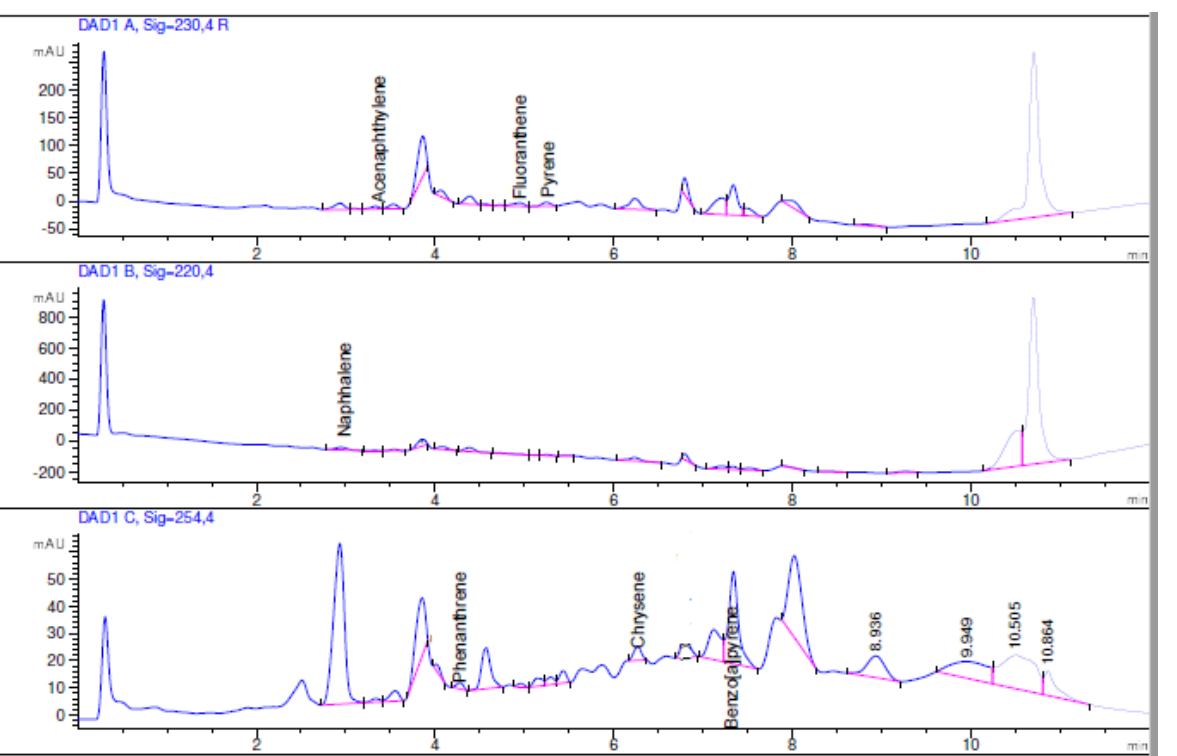
Figure 3. HPLC chromatogram of the non- spiked bark sample at λ = 230 nm, 220 nm , and 254 nm. All calibration curves show good linearity with R 2 values ranging between 0.9993 and 0.9998 (Table 2). Instrumental LOD and LOQ ranged from 0 .2 μg L −1 for Naph to 13.7 (Table 2). The instrumental repeatability values ( %RSD inst ) ranged between 0.006% and 4.6% (see Table 2), being within the interval values found in the literature (1 – 47.3%) [44,45] and indicating good instrumental precision. In general, the method repeatability (%RSD method ) was below 17% for the leaf and bark samples (Table 3), which is acceptable at such low concentration levels. An excep- tion is observed for IcdP in both sample types and for BghiP in leaf samples. The high variability of high-molecular-weight PAHs has also been shown in previous works [46] and could be due to the remaining co-extracted interferences from leaves and bark. Moreover, the %RSD method values were similar to those reported in the literature (up to 18.8% [8] and 31.4% [44]). Regarding recovery, the lowest values were found for the lighter PAHs, mainly Naph, Acy, and Ace (Table 3). The low recovery of the lighter PAHs could be due to the fact that they are more likely to be lost during sample handling and treatment, mainly in the evaporation/concentration step, and because lighter PAHs can penetrate further into the leaf tissues [47], making their extraction more complex. However, most %R values are within the 60 −1 20% range, which is accepted as valid [48]. 3.2. Real Contaminated Samples Figure 4 shows the experimental data for the non-spiked leaf and bark samples, specifically: (a) the distribution of PAHs according to the molecular weight classification (light-molecular-weight PAHs (LMW: 2 and 3 rings PAHs), medium-molecular-height PAHs (MMW: 4 rings) and high-molecular-weight PAHs (HMW: 5 and 6 rings)); and (b) the individual PAH concentration. The concentration of each PAH was corrected based